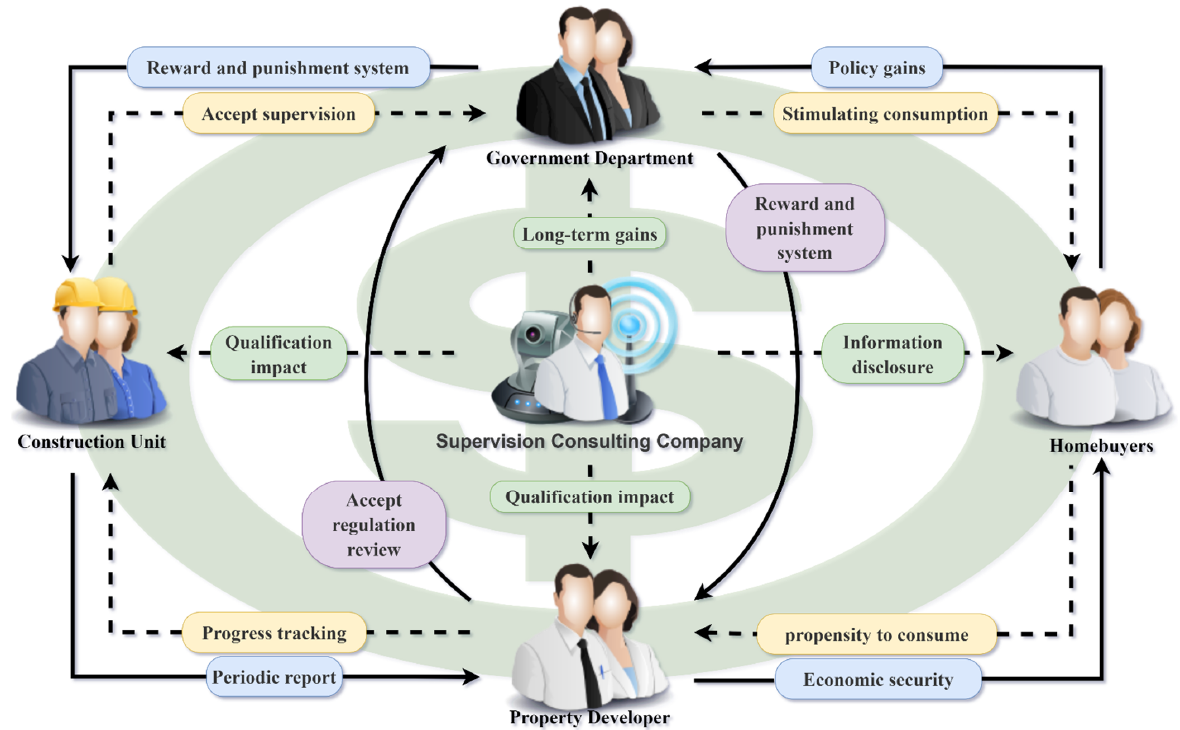
Figure 2. Quadripartite relationship diagram of government, construction unit, properly developer, and